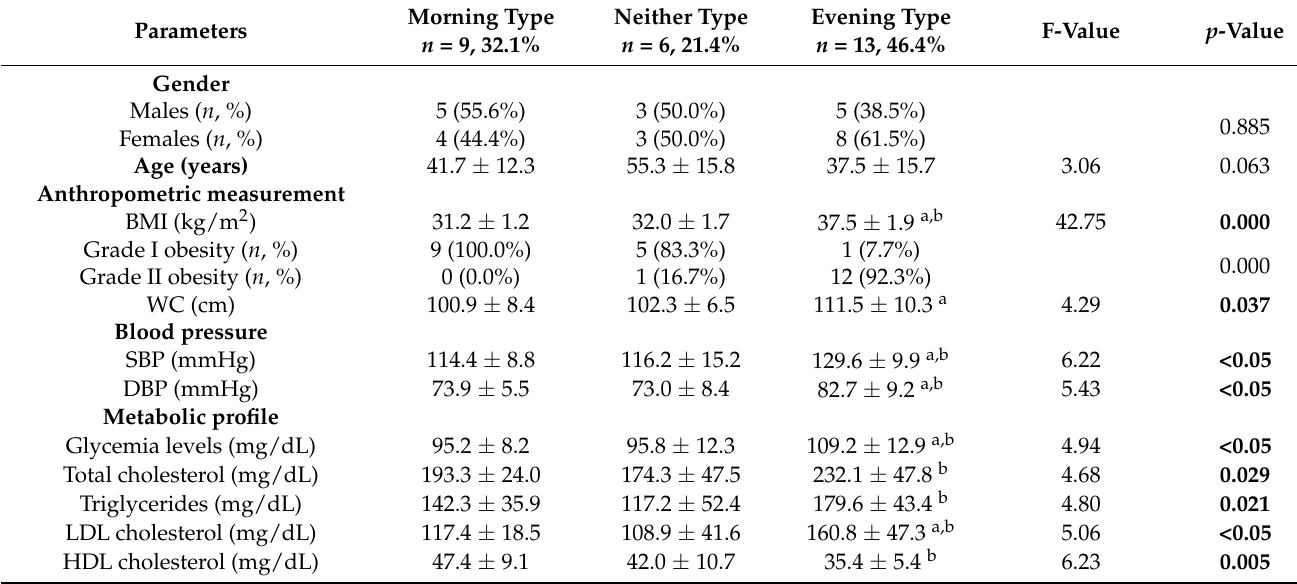
Figure 1. Prevalence in chronotype categories in patients and controls. Data are reported as Mean ± SD and percentage; p values < 0.05 were considered statistically significant. Table 3. Differences in study parameters of patient with craniopharyngioma according to chronotype categories.